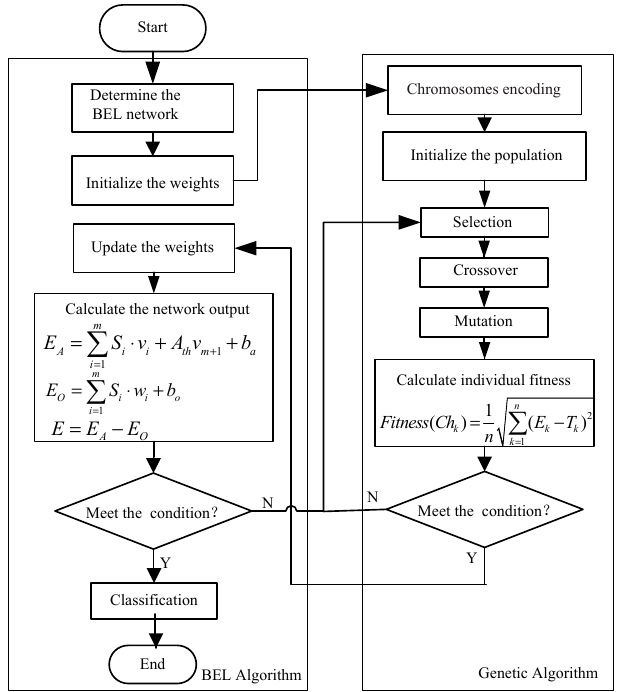
Figure 5. The flowchart of the GA-BEL algorithm.